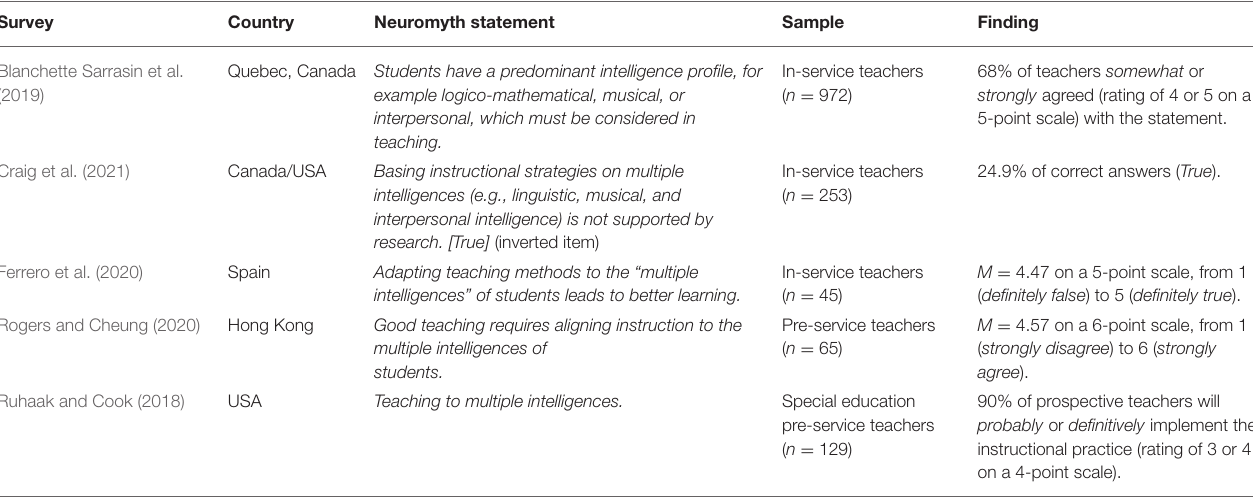
TABLE 1 | Prevalence of beliefs, among educators, about the false claim that tailoring instruction to pupils’ MI intelligence profiles promotes learning, in different countries around the